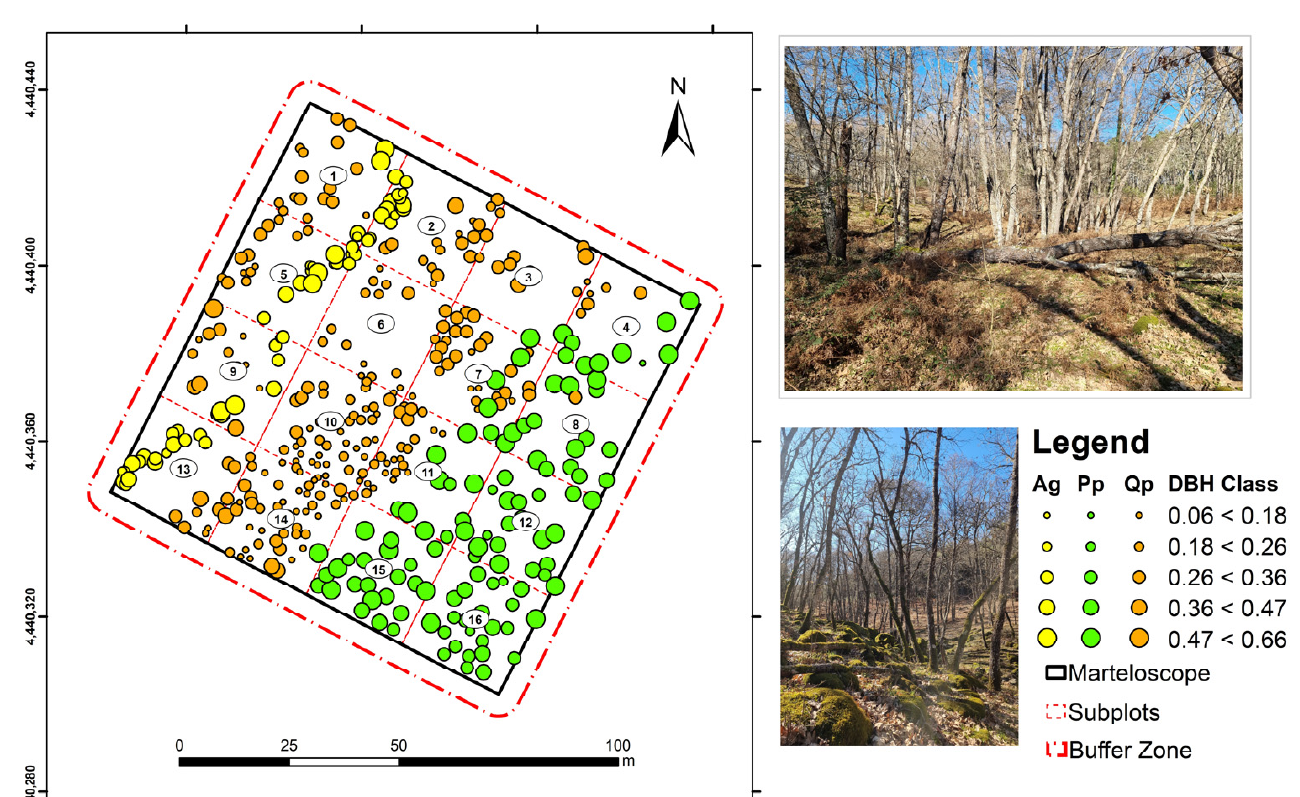
Figure 2. Map of the study area showing tree species (yellow: Alnus glutinosa (Ag); green: Pinus pinaster (Pp); brown: Quercus pyrenaica (Qp)) and diameter at breast height (DBH) scaled by symbol size. The perimeter of the marteloscope is outlined in black, and the 16 sub‑plots are delim‑ ited using red dotted lines. The 5 m external buffer represented with a red dashed‑and‑dotted line was used to process the laser scanning